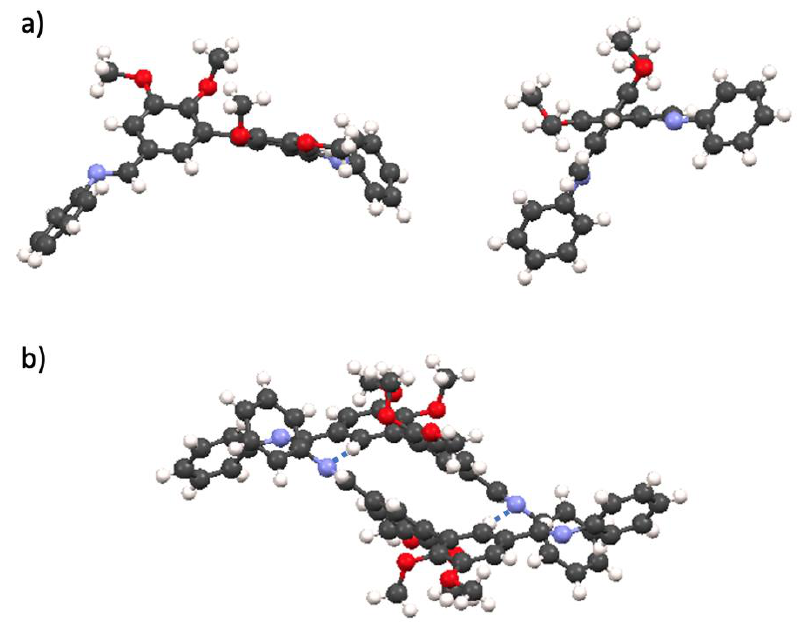
Figure 7. XRD structure of M4 . ( a ) side views and ( b ) packing, two molecules and short-contact interactions represented.